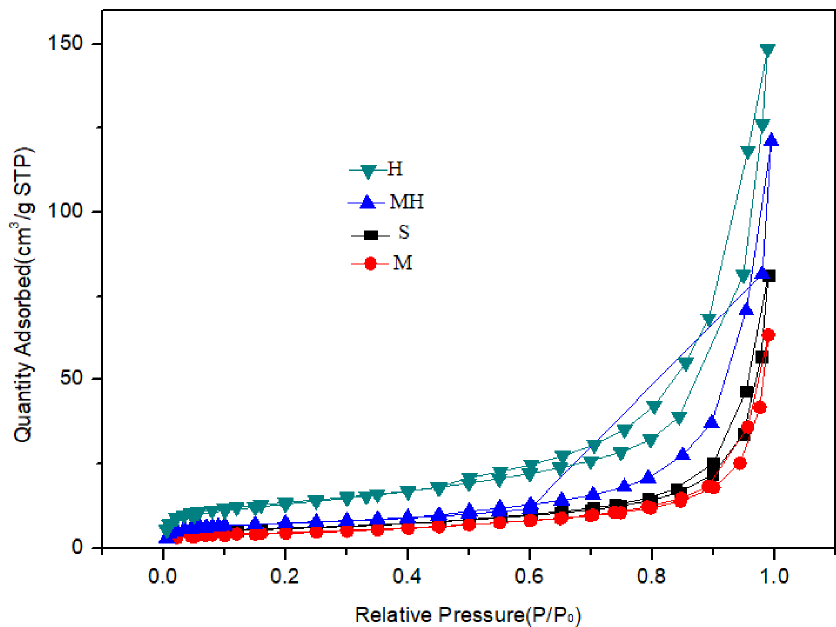
Figure 5. N 2 adsorption curves of the carrier samples.